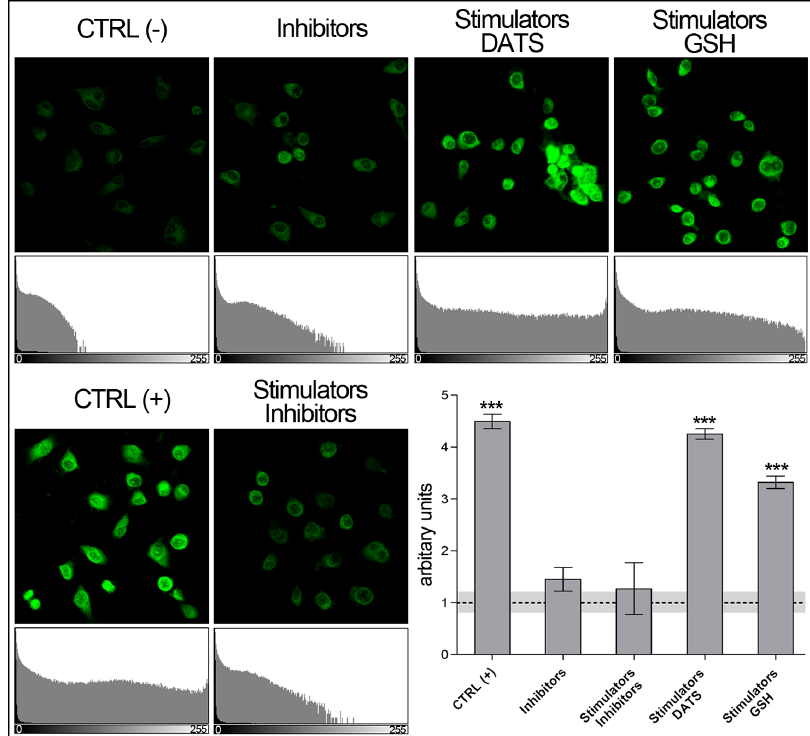
Figure 6. Detection of sulfane sulfur species using fluorescence microscope. Microphotographs of endothelial cells and corresponding histograms (below each microphotograph) show different sulfane sulfur-related fluorescence intensity, emitted by SSP4, in 3 h, with various treatments. Images analysis performed using ImageJ software and represented using arbitrary units (lower left diagram in each panel). Untreated control, CTRL (-), in diagram is indicated as dashed baseline; gray band is the relevant SD. Data depicted as the mean ± SD; p value versus the untreated control: ** p < 0.01, *** p < 0.001 (according to Student’s two-tailed t -test). CTRL (+)/Stimulators; 5 mM Cys, 5 mM vitamin B6, 10 µ M SAM. Inhibitors; 2 mM DL-PAG and AOAA.